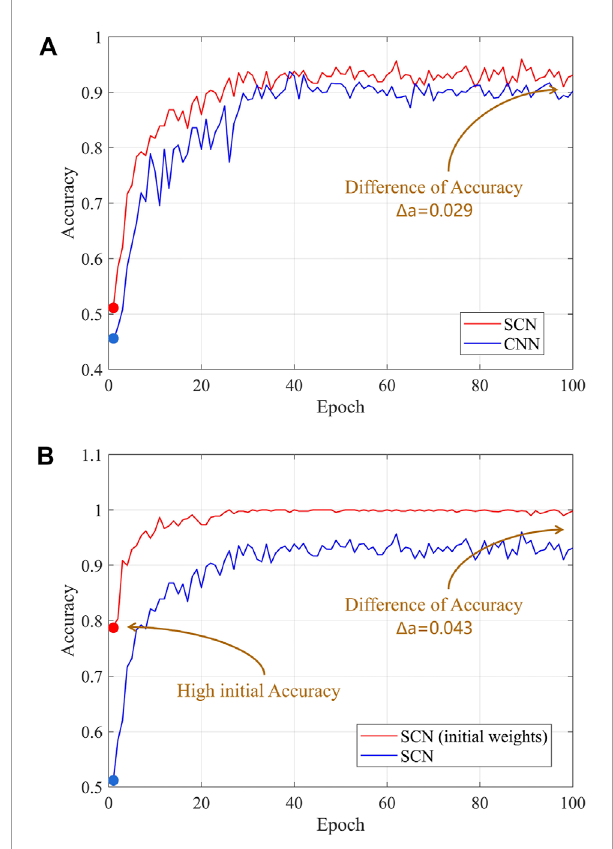
FIGURE 7 Training process of CNN, SCN, and SCN with initial weights. (A) Comparison between CNN and SCN, (B) comparison between SCN and SCN with initial